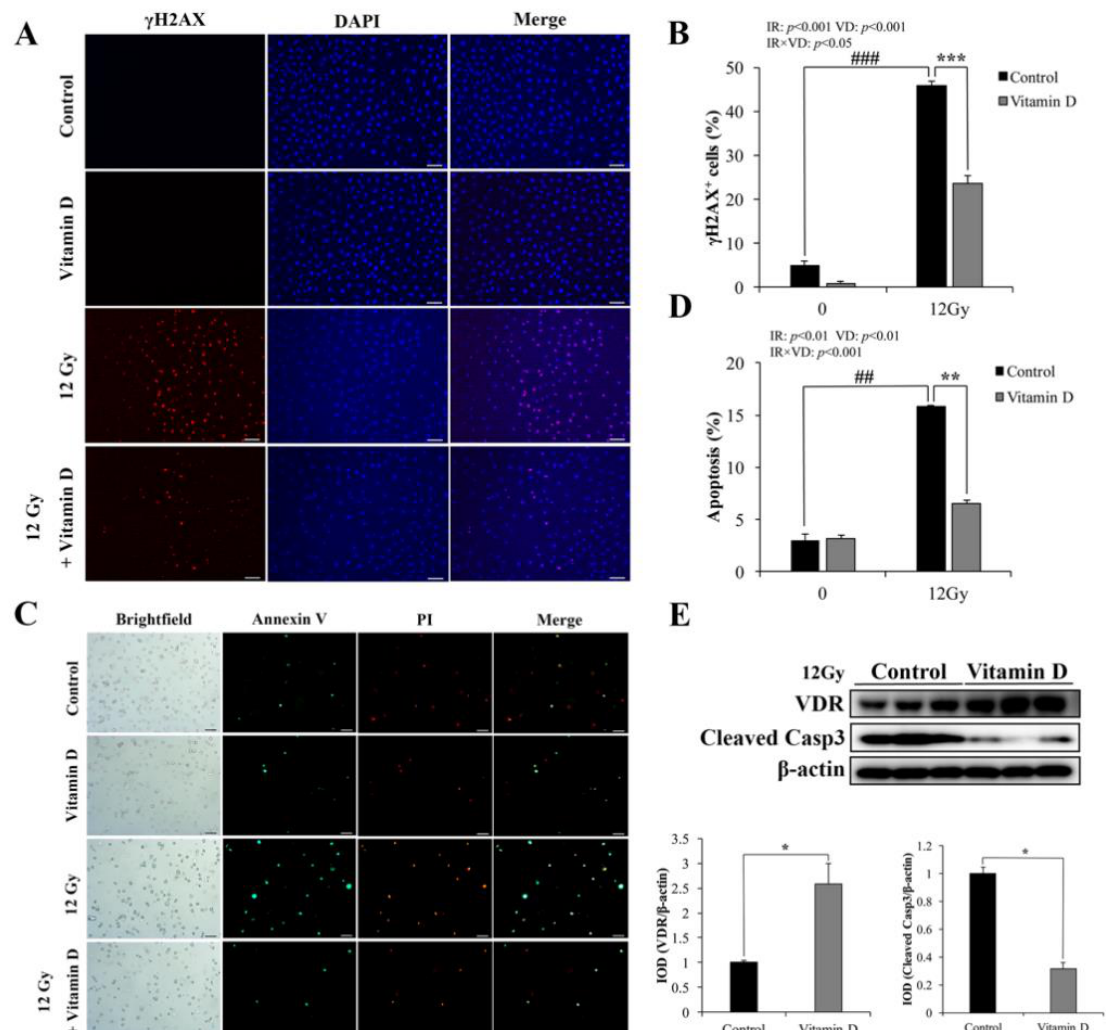
Figure 1. Vitamin D/Vitamin D receptor alleviates IR-induced DNA damage and apoptosis in IEC-6 cells. ( A ) Representative immunofluorescence (IF) images of γH2AX staining in IEC-6 cells at 1 h post 12 Gy IR pretreated 10 nM 1,25(OH) 2 D 3 . ( B ) Quantification of percentage of γH2AX + cells was analyzed. ( C ) Representative IF images of Annexin V/PI staining in IEC-6 cells at 24 h post 12 Gy IR pretreated 10 nM 1,25(OH) 2 D 3 . ( D ) Quantification of apoptotic cells with Annexin V-positive signaling was analyzed. # Compared with the 0 Gy-control group; * compared with the 12Gy-VD group. ( E ) Vitamin D receptor (VDR) and Cleaved Caspase 3 (Casp3) in IEC-6 cells were determined by WB at 24 h after 12 Gy IR pretreated with 10 nM 1,25(OH) 2 D 3 for 6 h. Quantitative analysis of Western blotting of VDR and Cleaved Casp3 expression. Values are means ± SD. * p <0.05, ** p < 0.01, *** p < 0.001; ## p < 0.01, ### p < 0.001. Scale bar, 20 μm.